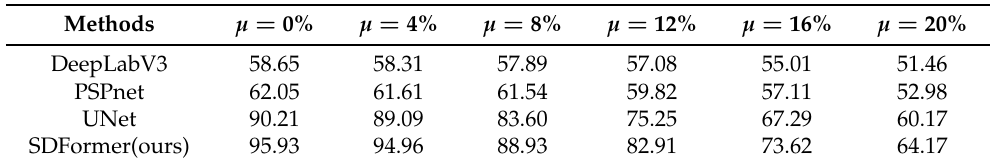
Table 4. MIoU of anti-noise test on sleeper beam dataset.